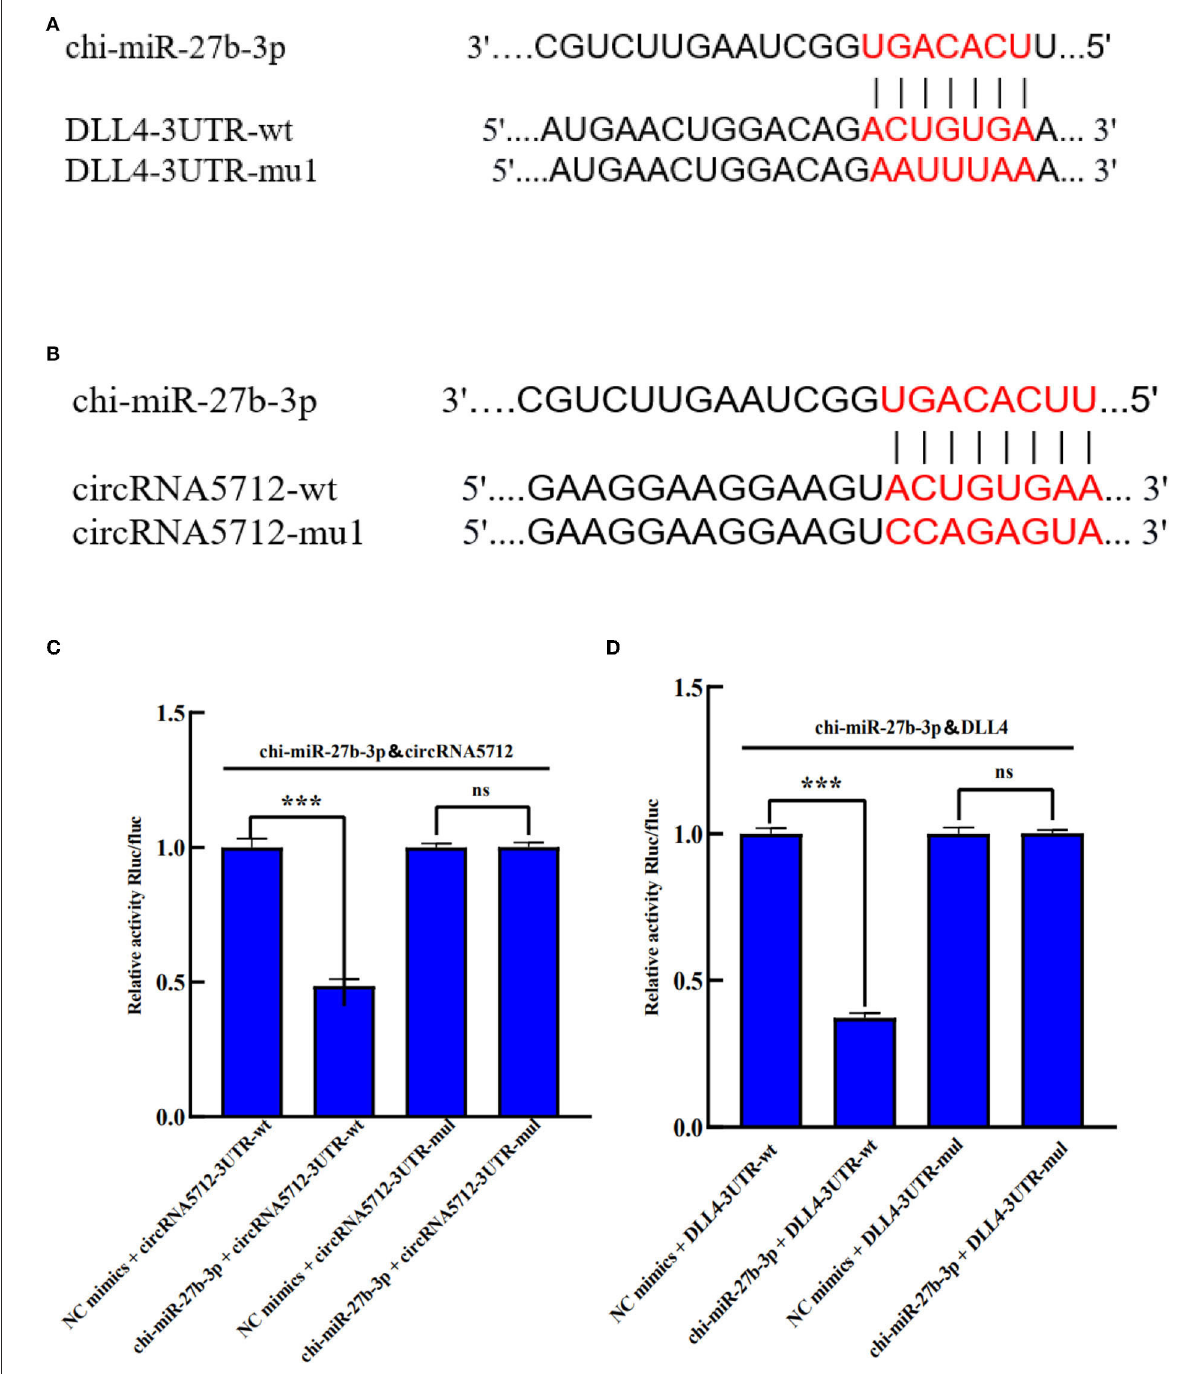
FIGURE10 Verification of the targeting relationship between circRNA5712, DLL4 and chi-miR-27b-3p in Inner Mongolia cashmere goat. (A) chi-miR-27b-3p and circRNA5712 3’-UTR binding sites and mutation sites. (B) chi-miR-27b-3p and DLL4 3’-UTR binding sites and mutation sites. (C) Verification of the interaction between chi-miR-27b-3p and circRNA5712 3’-UTR detected by a dual-luciferase reporter gene assay (*** P < 0.001). (D) Verification of the interaction between chi-miR-27b-3p and DLL4 3’-UTR detected by a dual-luciferase reporter gene assay (*** P < 0.001). Results in (C,D) are expressed as mean 6 standard error of the mean